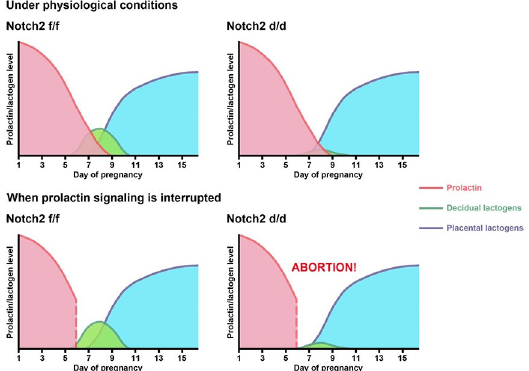
Fig 7. Working model. Under normal physiological circumstances, pituitary prolactin sustains CL function until mid- gestation, which is then taken over by placental lactogens. Decidual lactogens assist pituitary prolactin in pregnancy maintenance, while the latter plays the predominant role. Therefore, no obvious defects in fertility were noticed in Notch2 d/d mice. However, when the prolactin signaling is blocked, decidual lactogens were capable of ensuring progesterone production in Notch2 f/f mice, but Notch2 d/d mice experienced pregnancy loss due to insufficient level of decidual